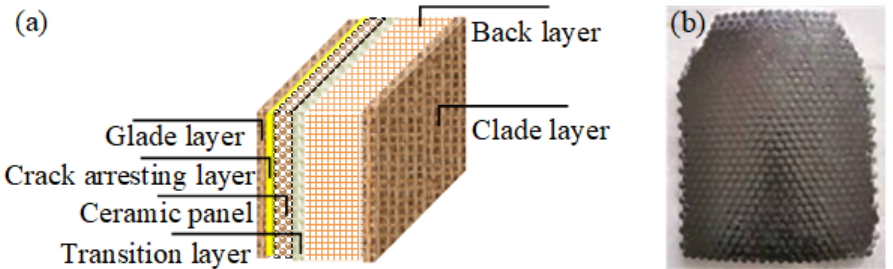
Table 3. Material parameters of the rotating band.